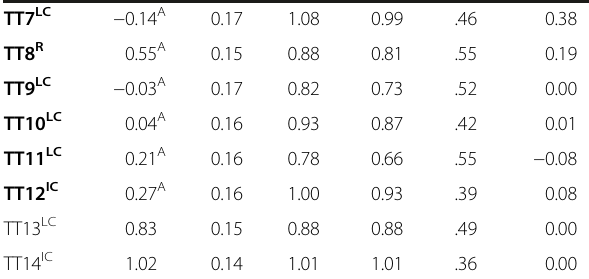
psychometric characteristics in this new analysis. Fit sta-